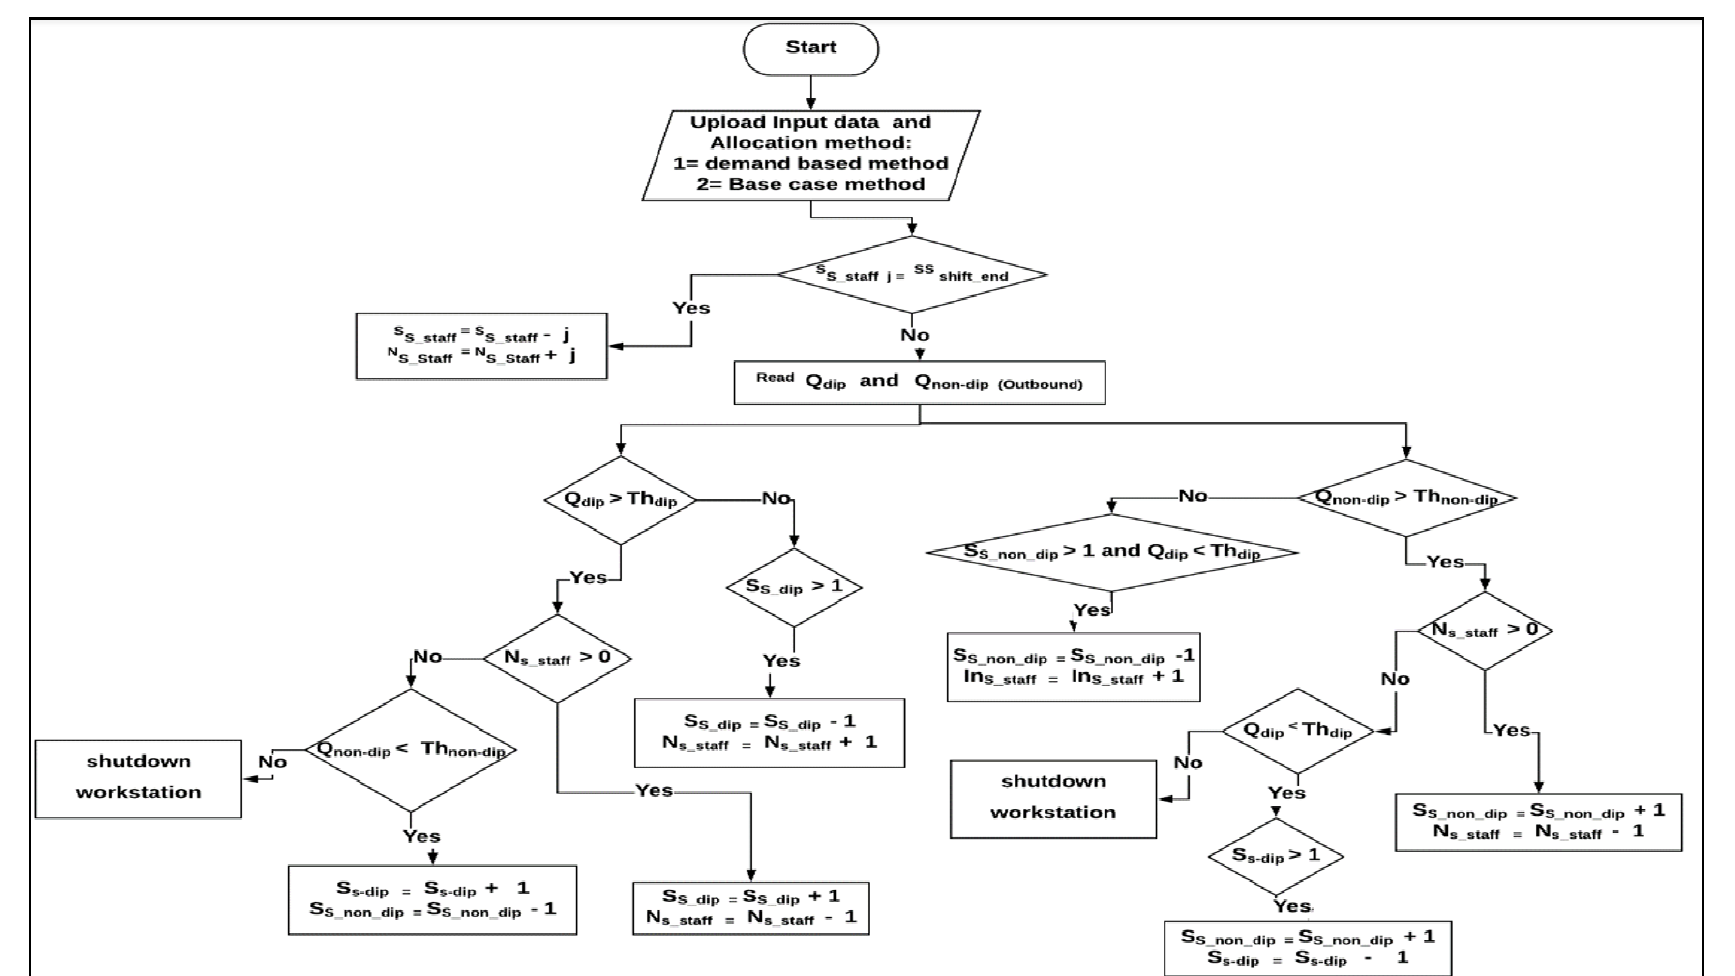
Figure 6. Phase one of algorithmic approach for security resource allocation management.